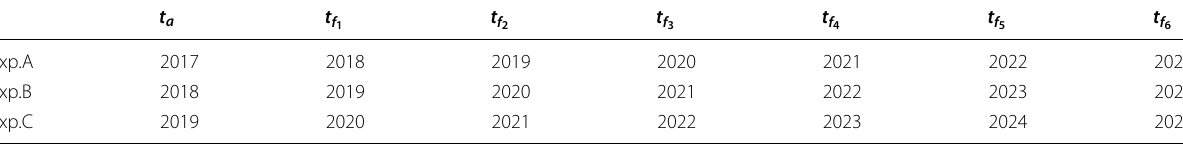
Table 3 Staggered forecast